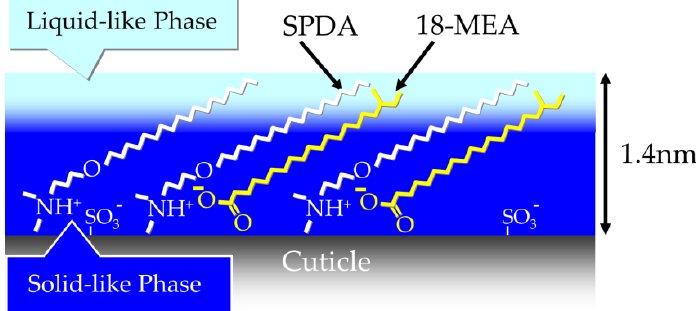
Figure 15. Schematic diagram of adsorption layer made of 18-MEA/SPDA at room temperature.